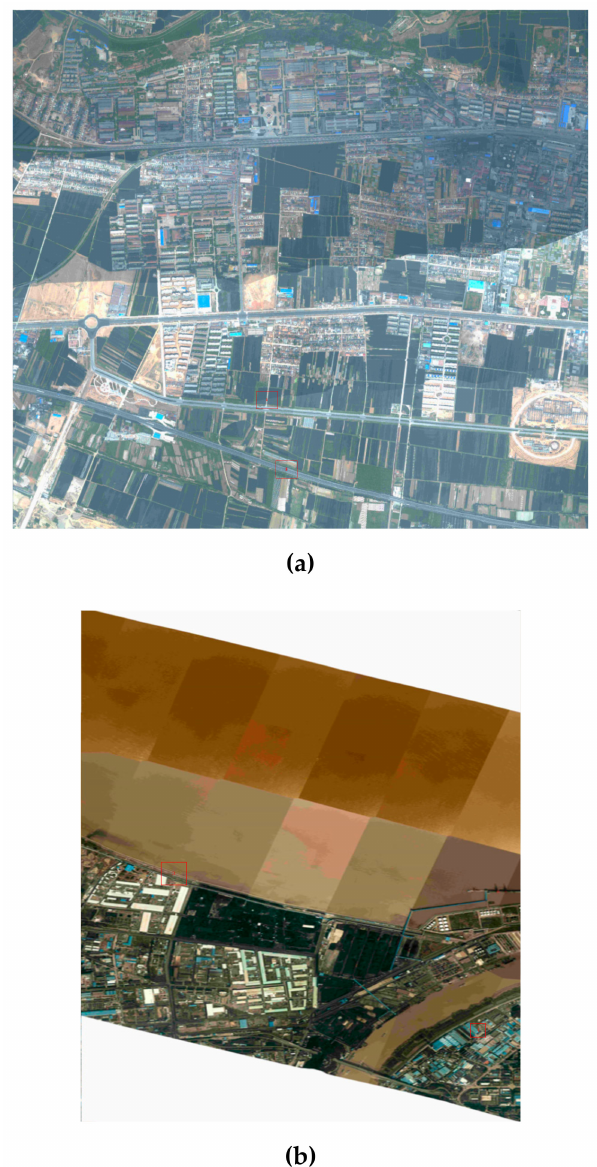
Figure 11. A panoramic view of the DOM generated with boresight misalignments calibration: ( a ) Dataset 1; and ( b ) Dataset